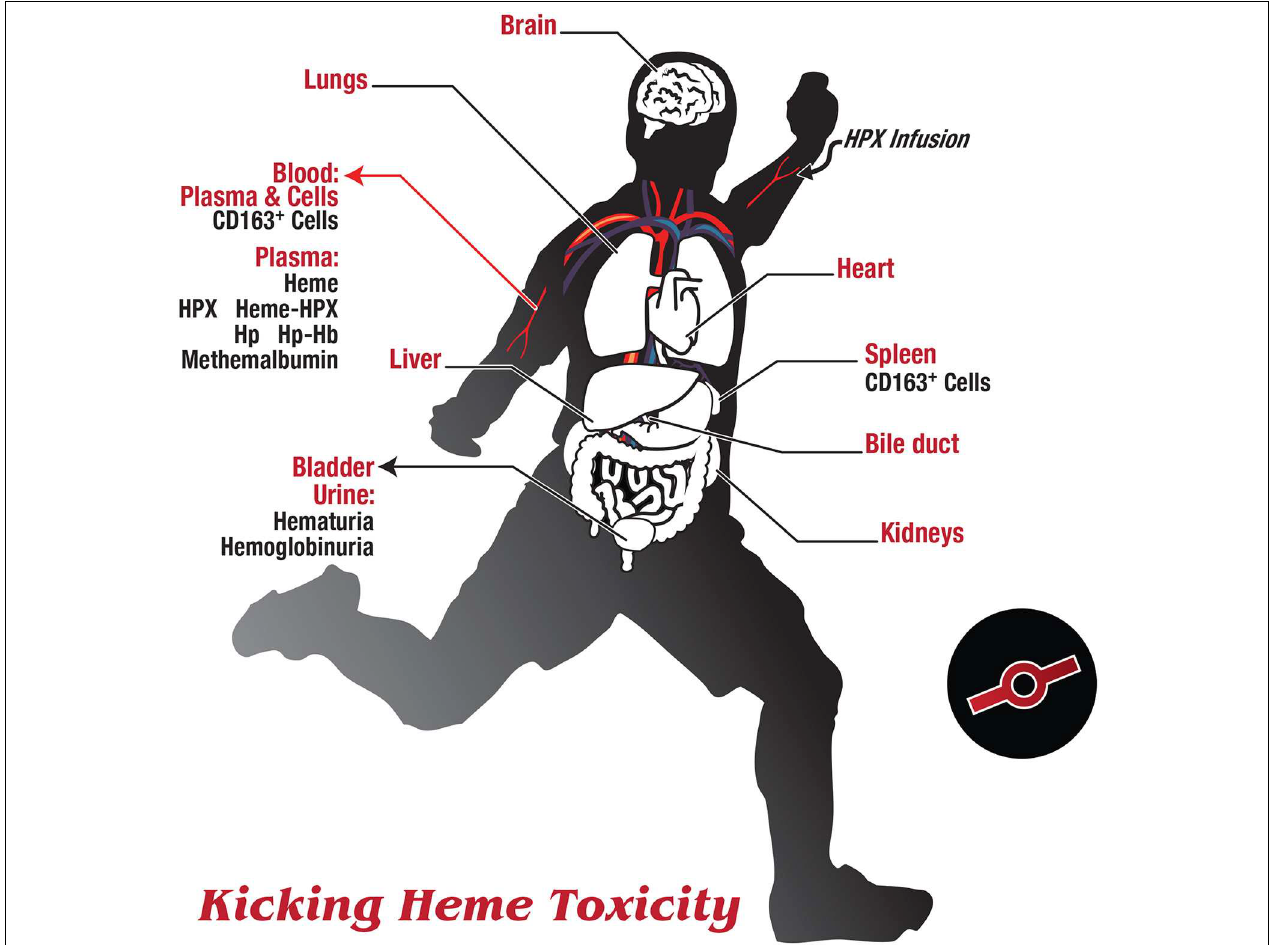
blood and urine samples are indicated here, in addition to the standard liver and kidney function tests and parameters used for the hemolytic index. If routinely measured, e.g., free heme, free HPX and free Hp in plasma, and heme in urine should prove useful in diagnosis and help discern when there is impaired heme clearance due to a HPX deficiency state. As endothelial cells die and lyse they may be the principal source of plasma HO1 (Ghosh et al., 2011) and also raise LDH levels (Drieghe et al., 2013). The soluble ectodomain (sed) of scavenger receptors are released into the circulation